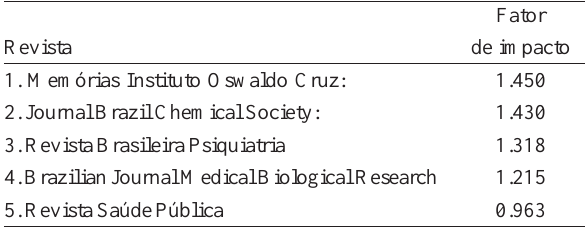
Tabela 3. Fatores de impacto JCR das cinco maiores revistas brasileiras em 2008.